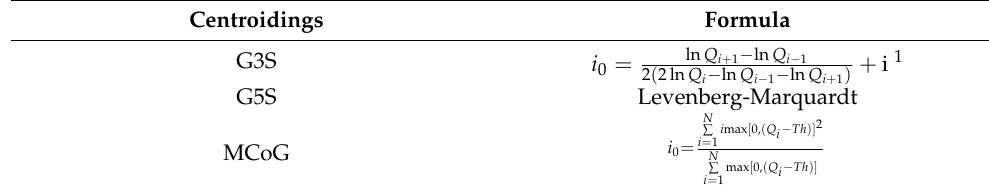
Table 3. Different centroiding algorithms.